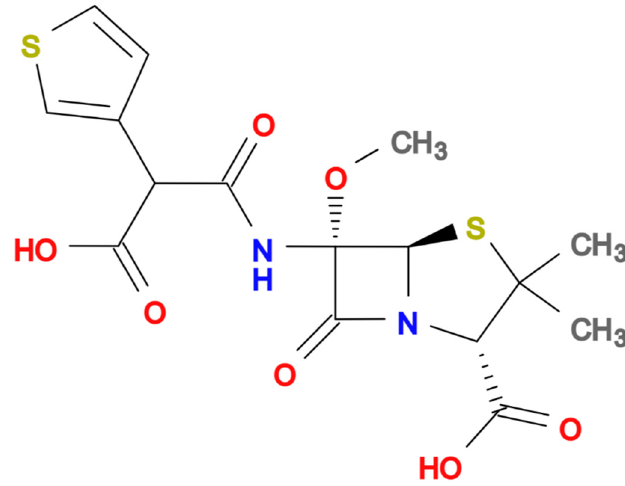
Figure 1. Chemical structure of Temocillin.